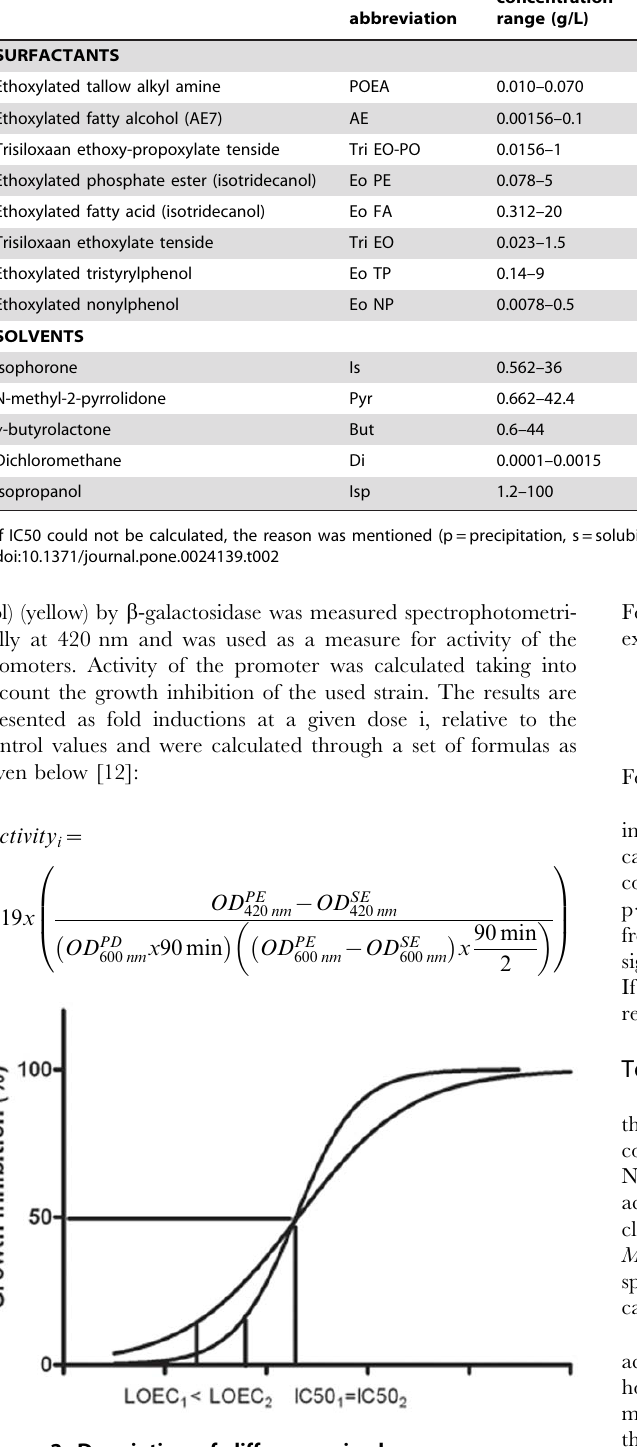
Figure 2. Description of differences in dose-respons curves, IC50 concentrations are equal but LOEC values differ due to differences in slope. doi:10.1371/journal.pone.0024139.g002 PLoS ONE |